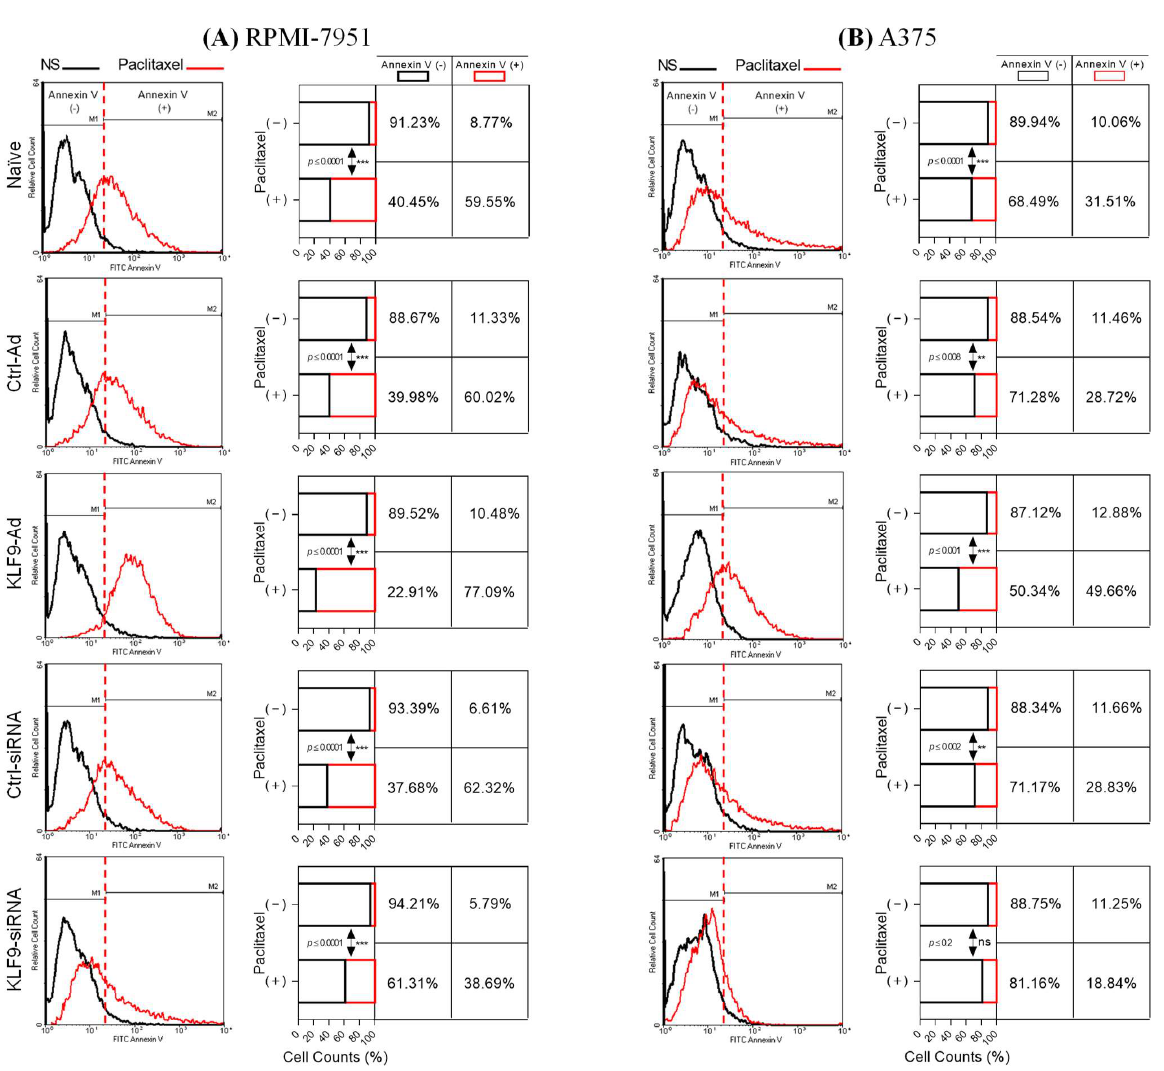
Figure 4. Flowcytometry analysis of malignant melanoma cells stained with annexin V-FITC apoptosis detection dye. Flow cytometry histograms (left panels) and stacked bar graphs (right panels) depict the effect of KLF9 adenoviral overexpression or siRNA knockdown on paclitaxel-induced apoptosis in RPMI-7951 ( A ) or A375 cells ( B ). Twenty-four hours post-viral transduction or siRNA transfection, cells were treated with paclitaxel (100 nM, for 24 h). Annexin V-FITC staining was performed as described in the methods section. Data ( n = 5), ns p > 0.05, ** p ≤ 0.01, *** p ≤ 0.001 vs. none-stimulated